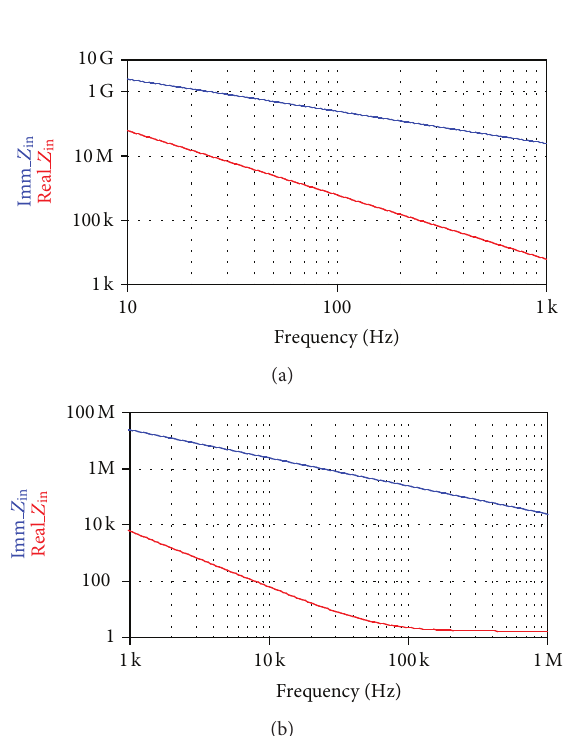
T 2: Main performance of the RFID systems (passive tags) for marble slab detection. RFID System LF 125kHz HF 13.56MHz UHF 868MHz Radiated power 100mW 50mW 500mW Max. stone detection distance 15cm 8cm 40cm < < Best tag placement Side surface of the marble slab Embedded in the conveyer belt or under it < < With water Works Does not work With dust/dirt/stone residuals Works